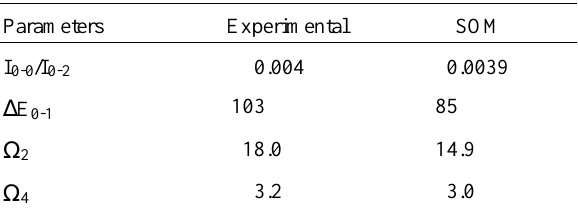
Table 2. Experimental and theoretical values of I 0-0 /I 0-2 , D E 0-1 (cm -1 ), W 2 and W 4 . (10 20 cm 2 ).